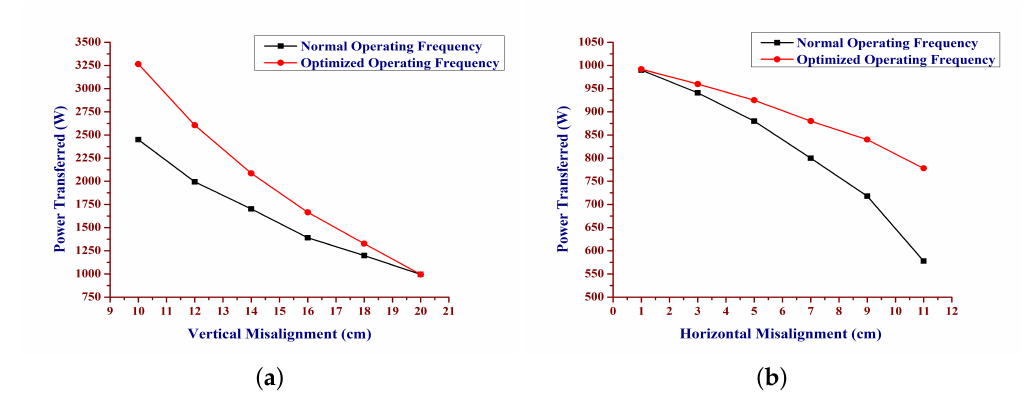
Figure 15. Power transfer level corresponding to the misalignment. ( a ) Power transferred corresponding to the vertical misalignment. ( b ) Power transferred corresponding to the horizontal